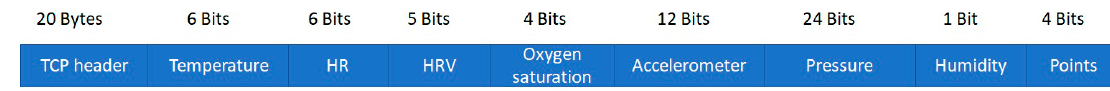
Figure 5. Message format of our system.